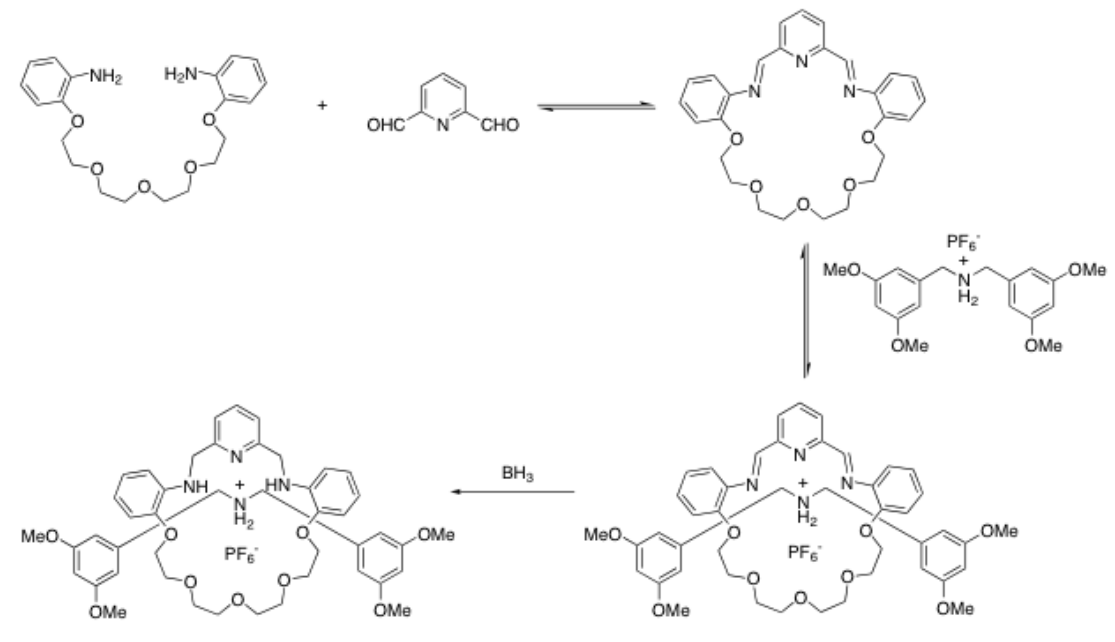
Scheme 14. Rotaxane formation through clipping of the